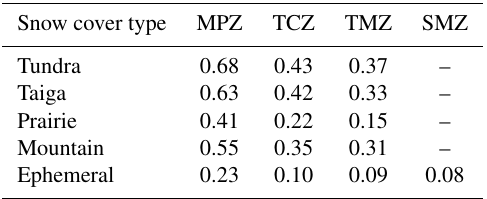
Table 3. The values of the empirical parameter k used to estimate snow sublimation (Eq. 7) for different climate zones and different snow types.